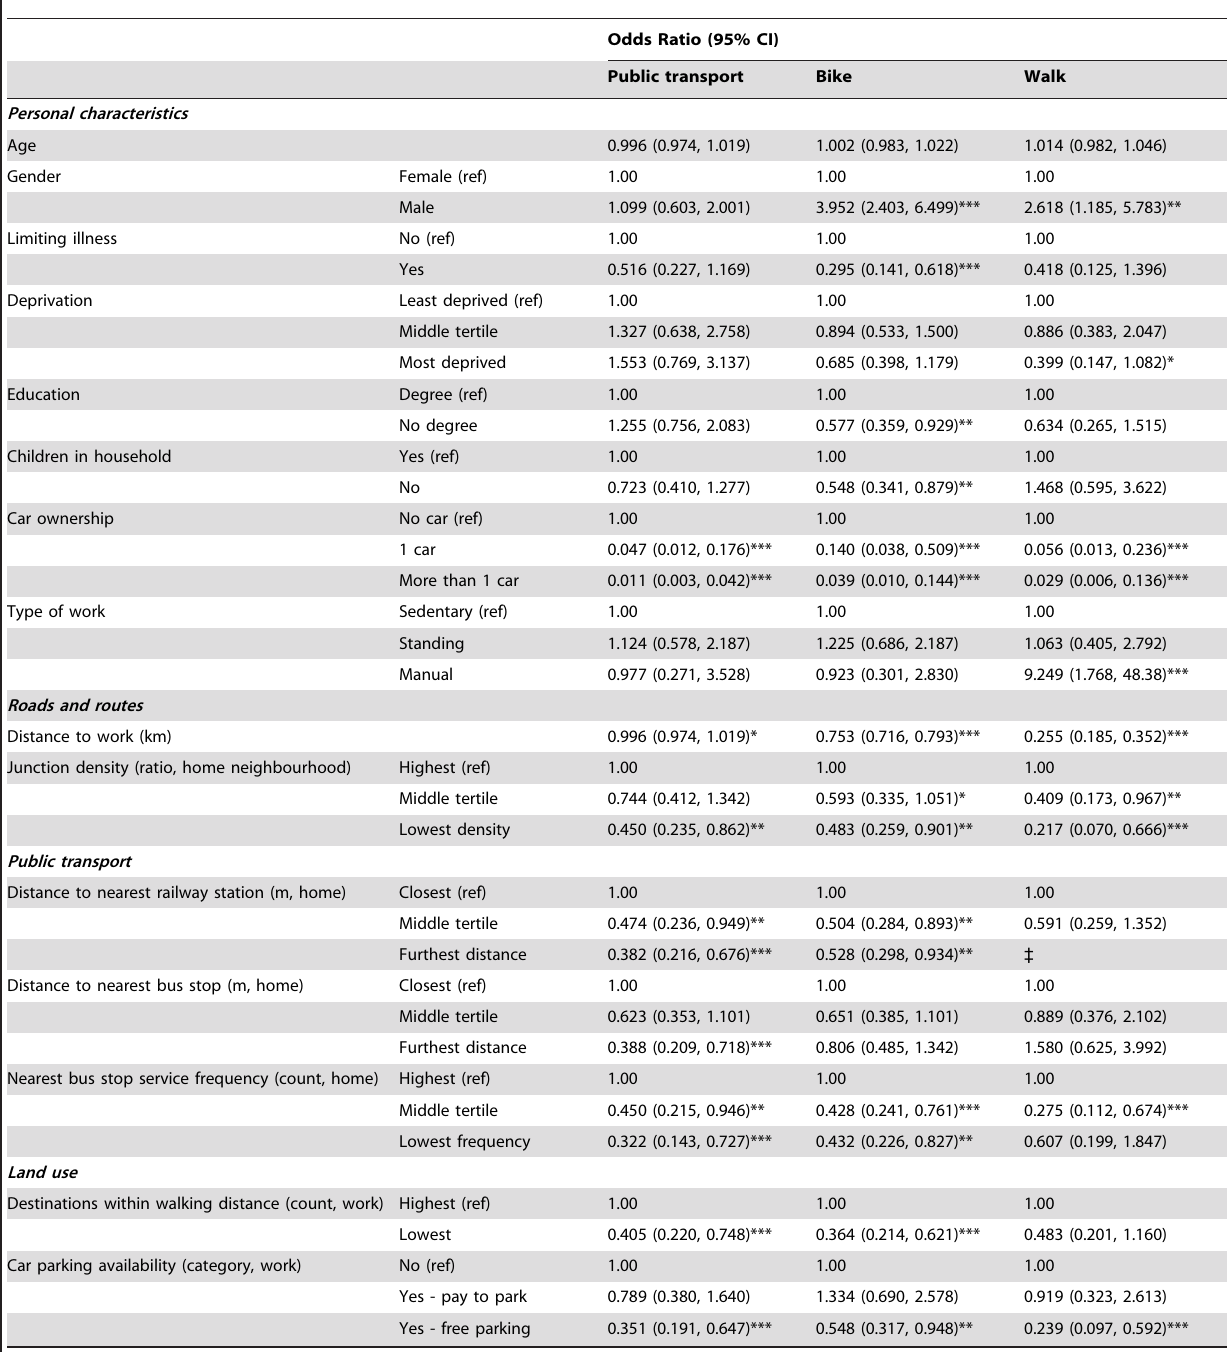
Table 3. Adjusted associations (from best-fit multivariable model) between personal and environmental characteristics and main mode of travel to work (reference category is ‘car’) (pseudo r 2 =